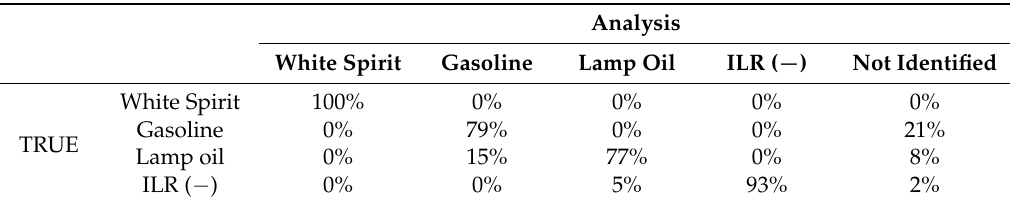
Table 8. IL classification for burn experiments ( n = 85, 40 burn experiments in which IL was detected and 45 burn experiments without